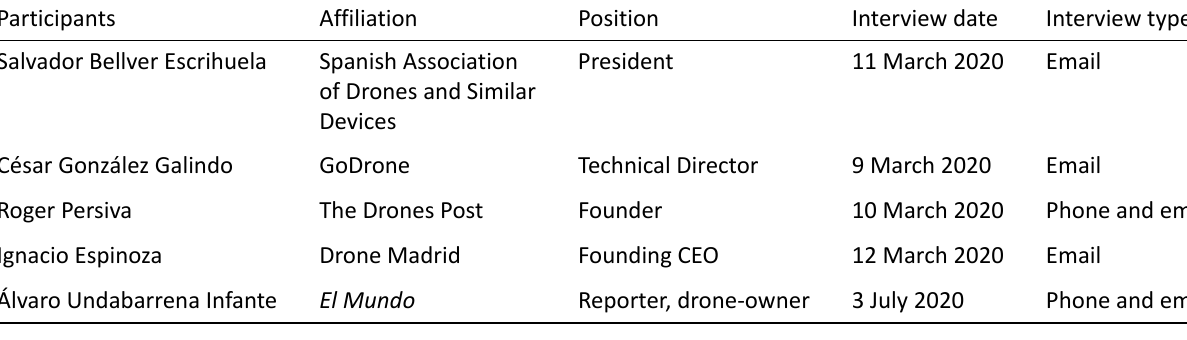
Table 2. Panel of experts representing drone journalists who provide aerial news footage to the media.